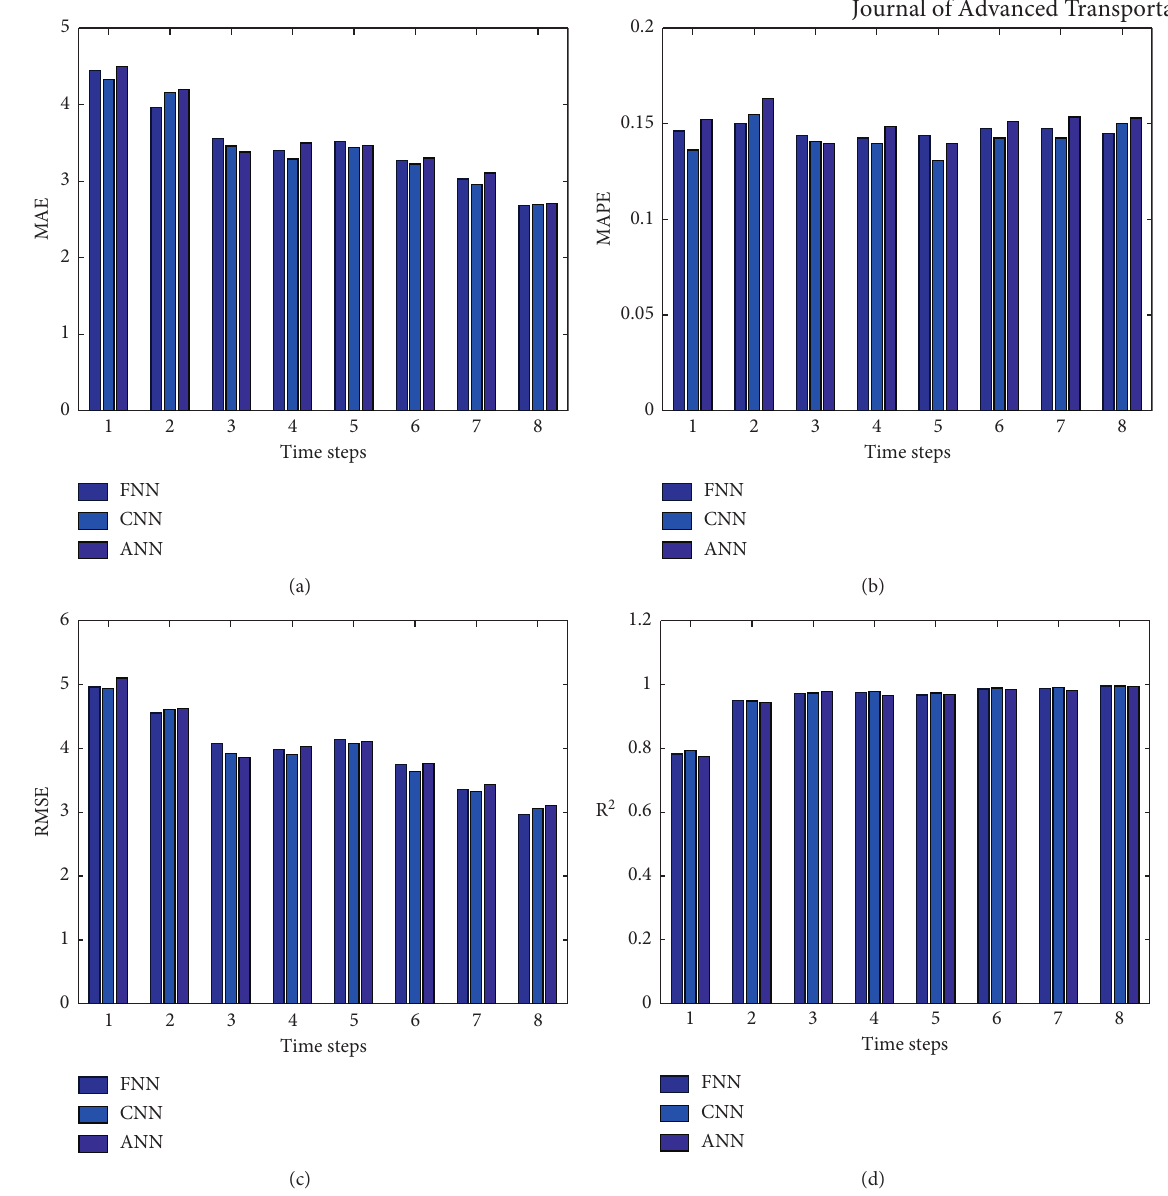
Figure 8: Prediction errors with different prediction